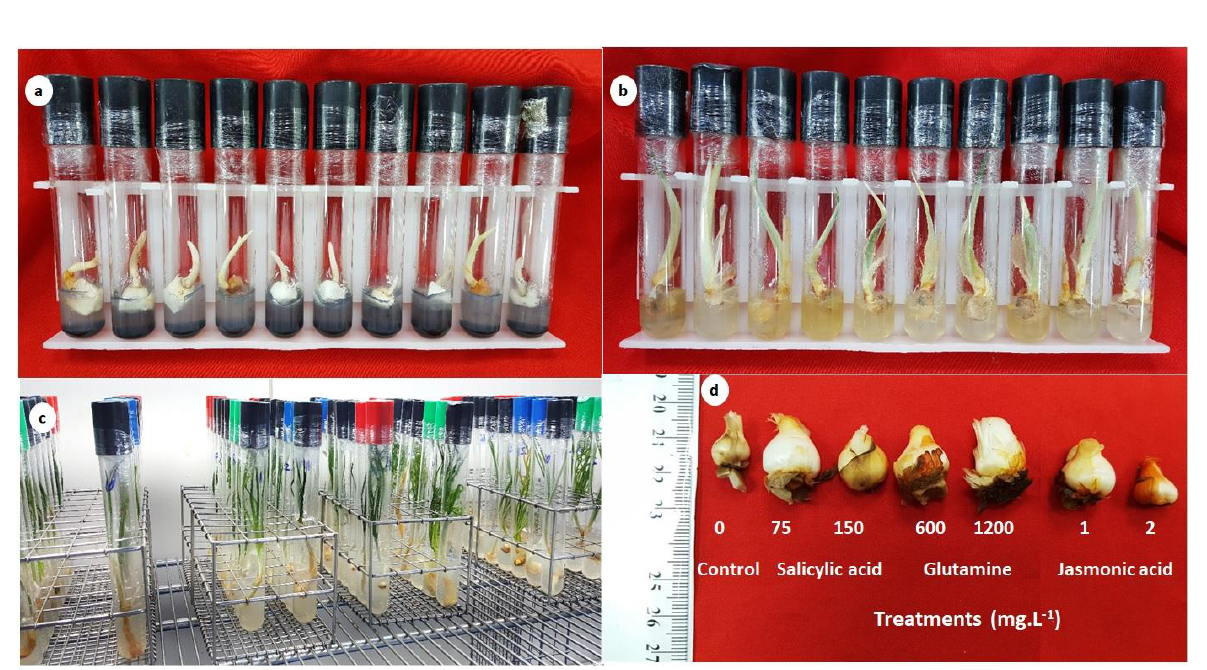
Figure 4. Influence of salicylic acid, glutamine, and jasmonic acid on saffron daughter corm formation using apical bud explants: ( a ) Surface disinfection and bud break of saffron apical buds cultured on MS medium supplemented with 3% sucrose and 1 g L −1 of activated charcoal 2 weeks after incubation; ( b ) Shoot development of saffron apical buds and growth 6 weeks after incubation; ( c , d ) Daughter corm formation 12 and 16 weeks, respectively, after treatment with salicylic acid (75 and 150 mg L −1 ), glutamine (600 and 1200 mg L − 1 ), and jasmonic acid (1 and 2 mg L −1 ).